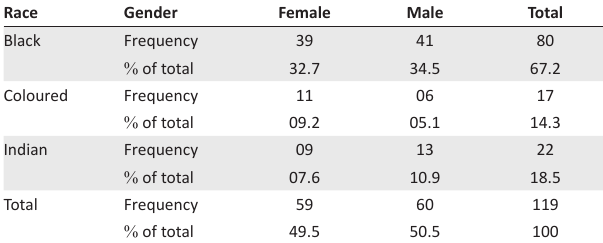
TABLE 1: Sample frequencies: Race and gender ( n =